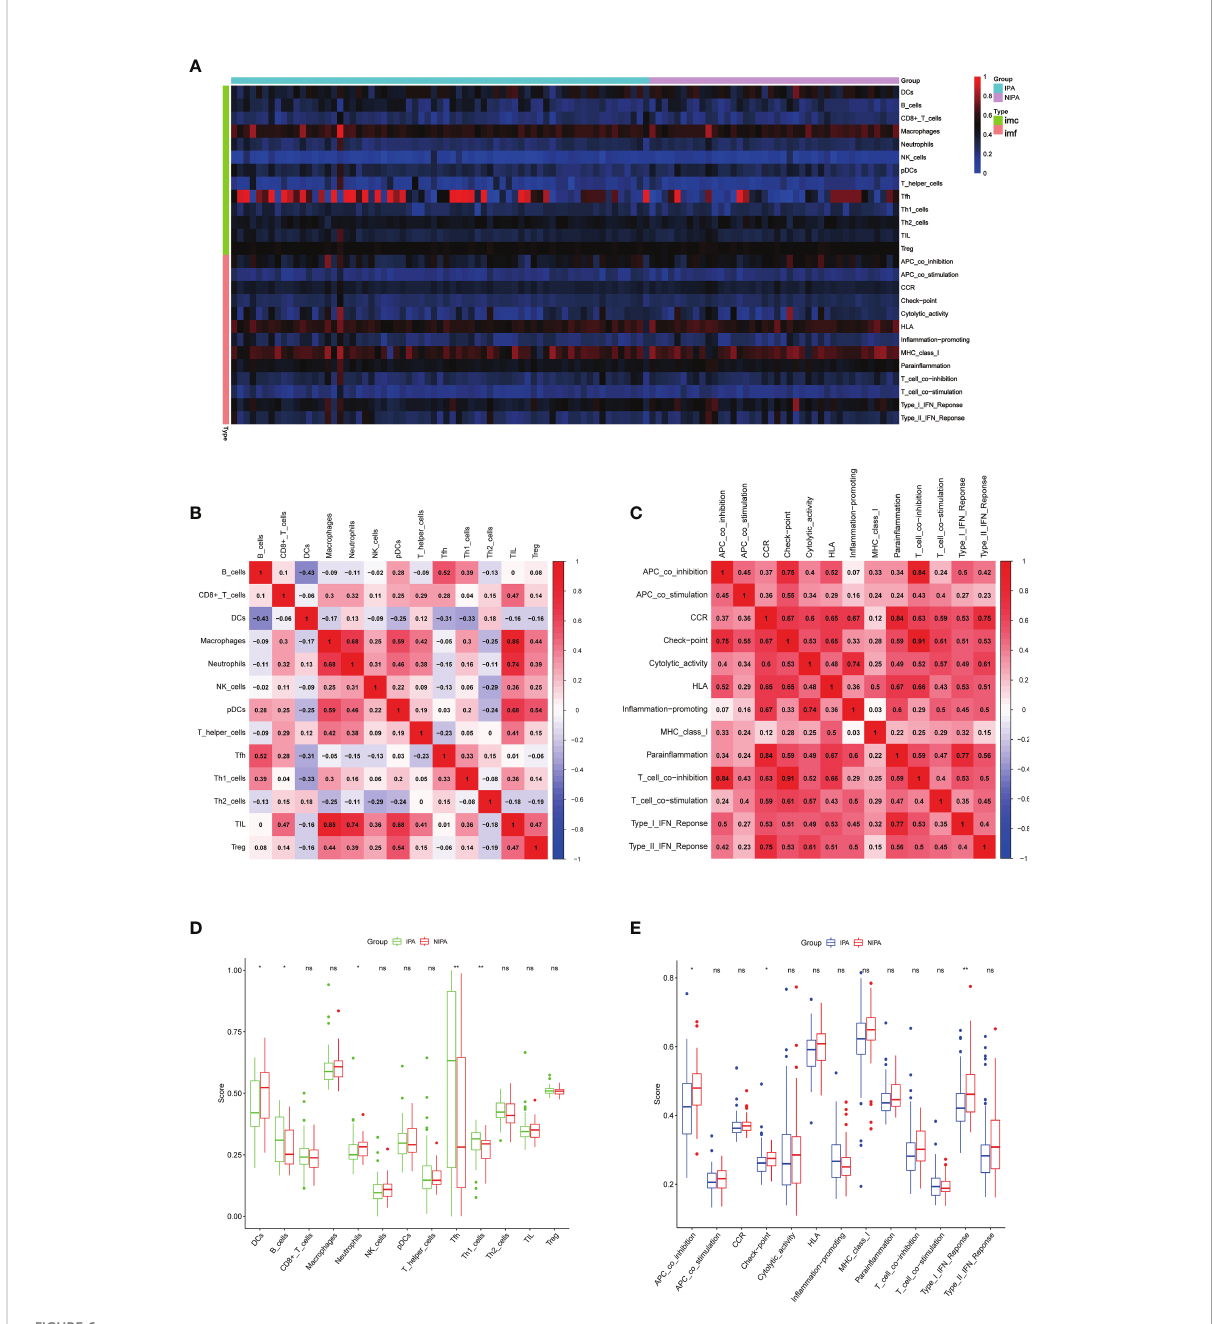
FIGURE 6 Analysis of immune in fi ltration. (A) Immune-related heatmap. (B) Rectangular diagram of immune cells. (C) Rectangular diagram of immune function. (D) Differences of immune cells when compared between IPA samples and NIPA samples. (E) Differences in immune function when compared between IPA samples and NIPA samples. * indicates P < 0.05, * indicates P < 0.01, ns indicates no signi fi